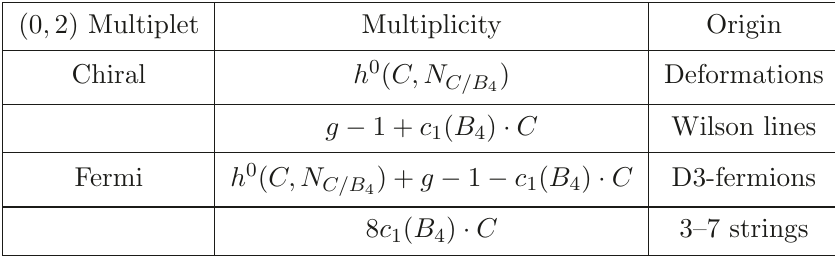
Table 3 . Matter spectrum on a D3-brane on curve C on B 4 of genus g